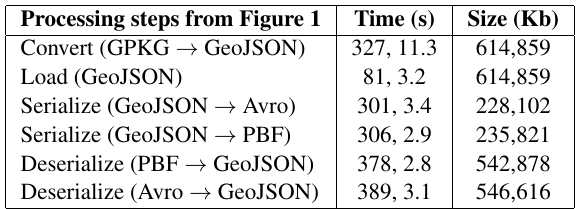
Figure 1. The main processing steps for serialization/deserialization of the input datasets.